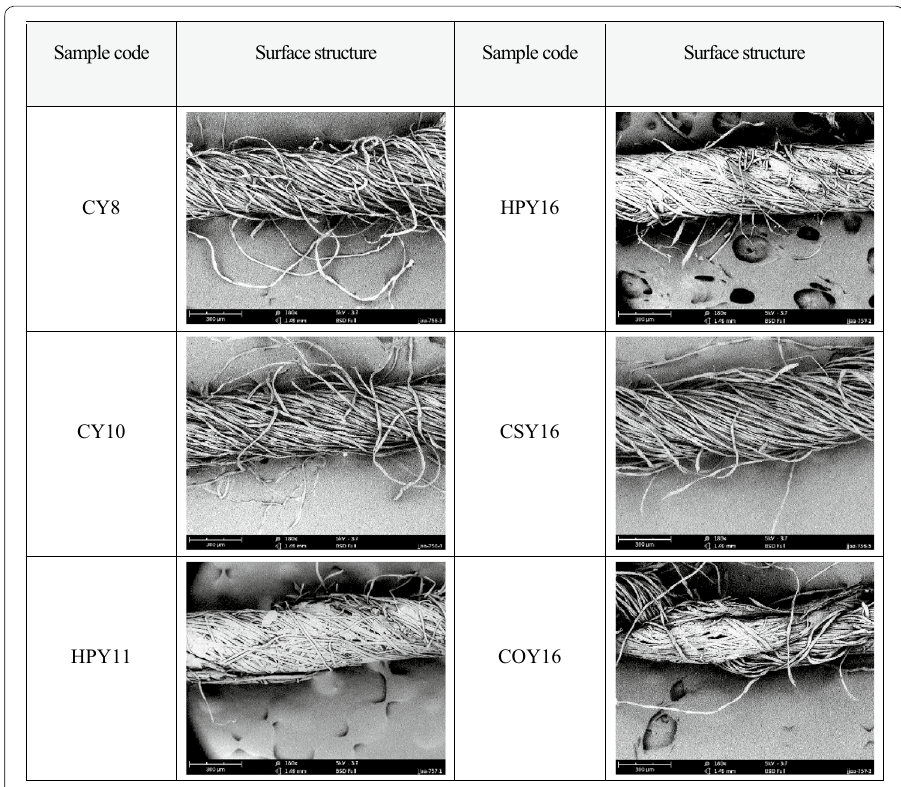
Fig. 3 SEM micrographs of the surface structure of warp and weft